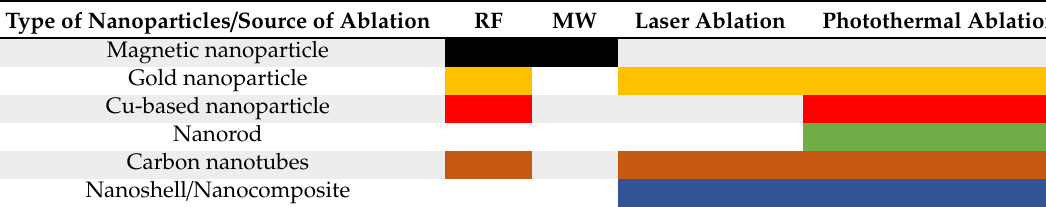
Table 7. Summary on types of nanoparticles and ablation